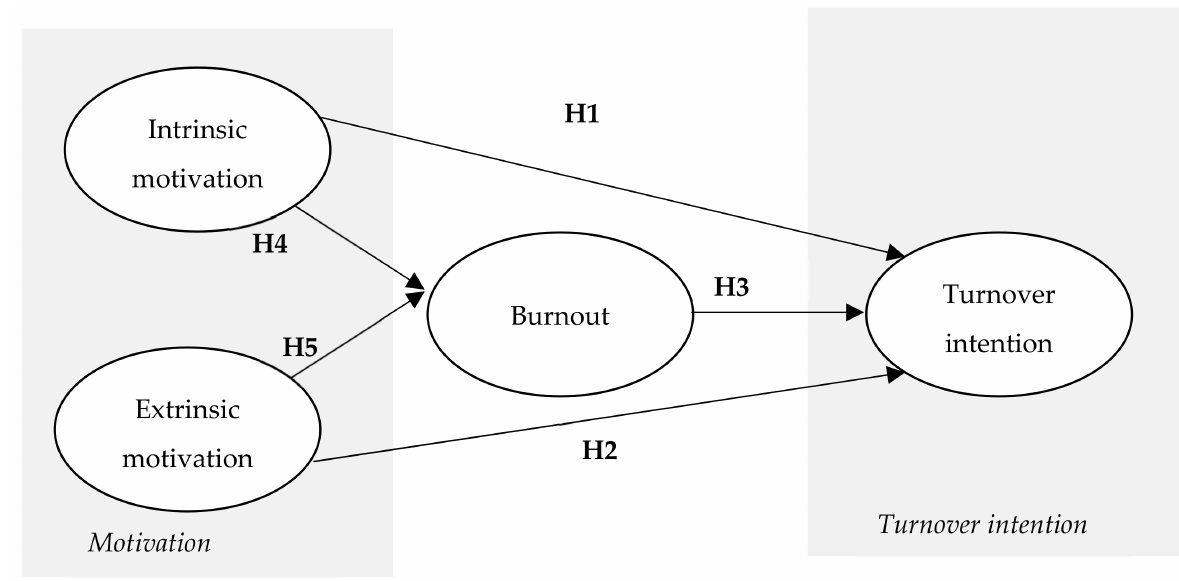
Figure 1. Proposed conceptual model.